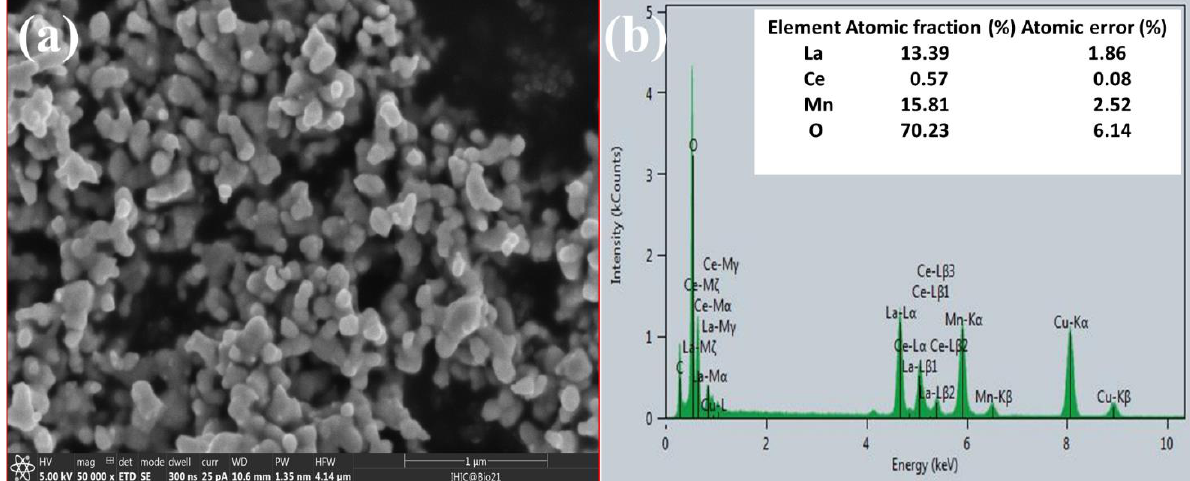
Figure 3. ( a ) UV-Vis diffuse reflectance spectra and ( b ) Tauc plot of as-synthesized CLMO photocatalyst.